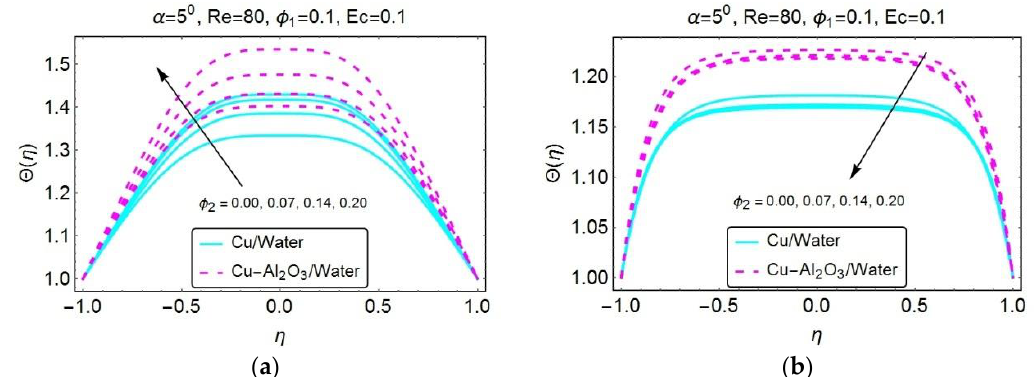
Figure 7. Stimulus of ϕ 2 on Θ(η) : ( a ) convergent case and ( b ) divergent channel. Energies 2020 , 13 , x; doi: FOR PEER REVIEW